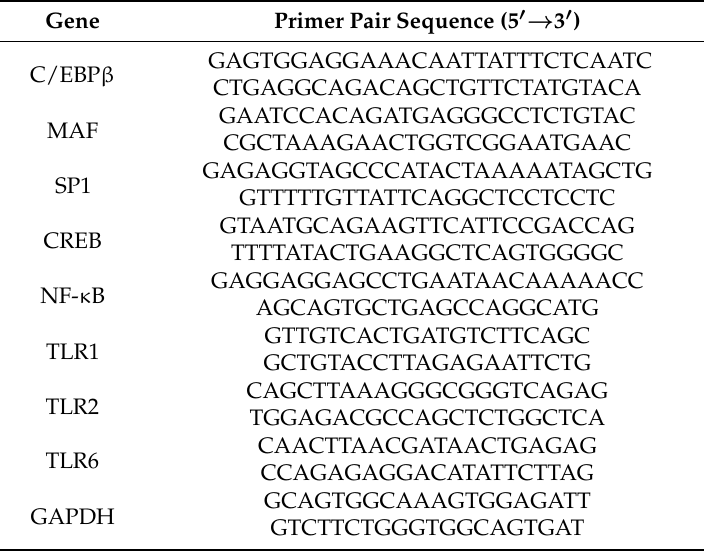
Table 2. PCR primers used for qPCR. Gene Primer Pair Sequence (5 (cid:48) → 3 (cid:48)